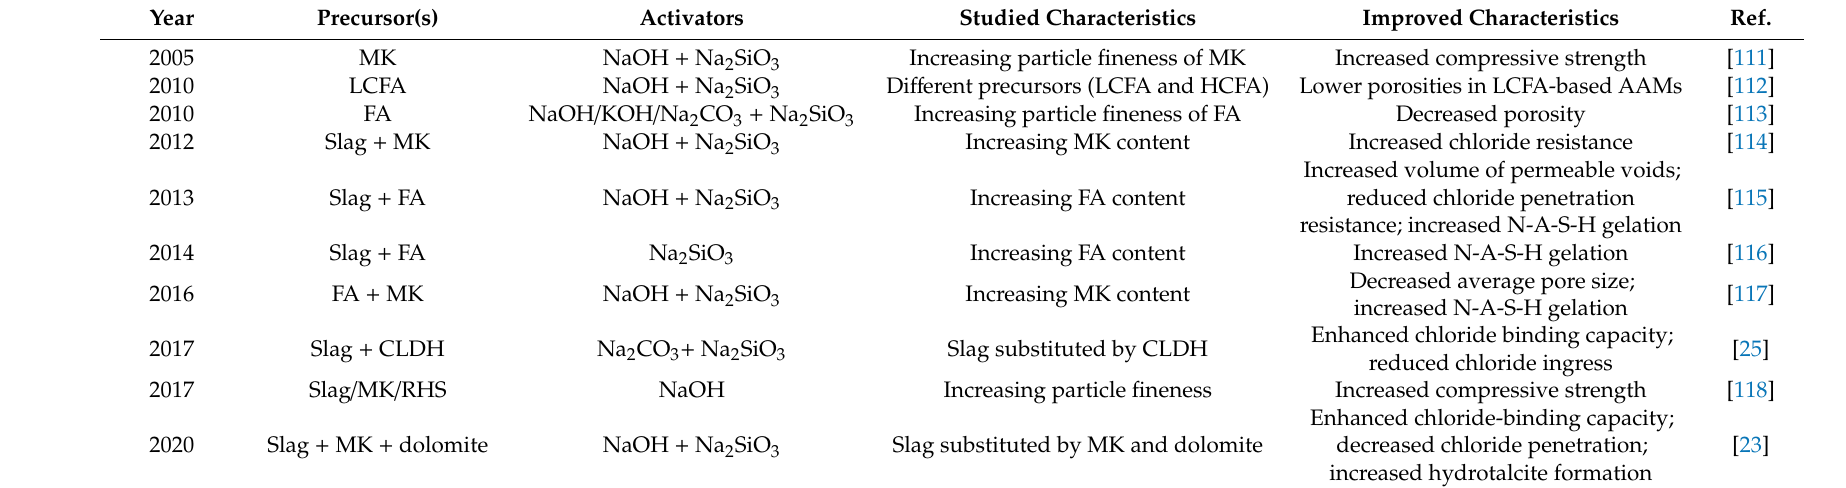
Table 3. Properties of precursors a ff ecting the chloride resistance of